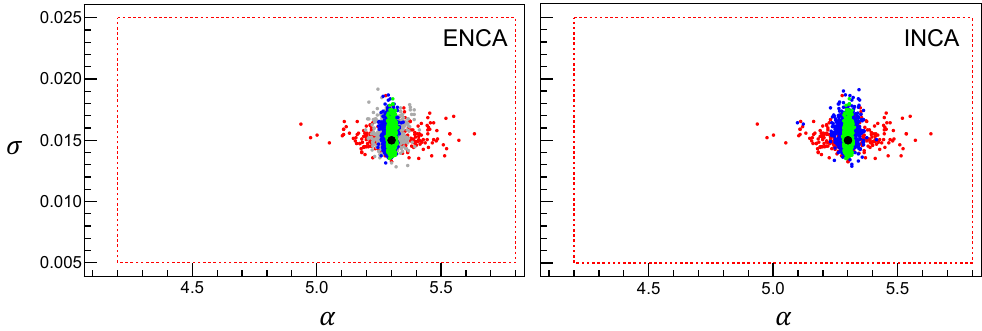
Figure 6: Metropolis-generated posterior for model (9) (green, representing the ground truth) compared against ABC posteriors using all three latent variables (blue) from ENCA (left) and INCA (right) and using only the two MLE-regressors (red). The posterior resulting from only two ENCA-generated summary statistics is shown in grey. The dashed boxes represent the ABC priors, while the black dots represent the true values of the parameters used to generate the synthetic data